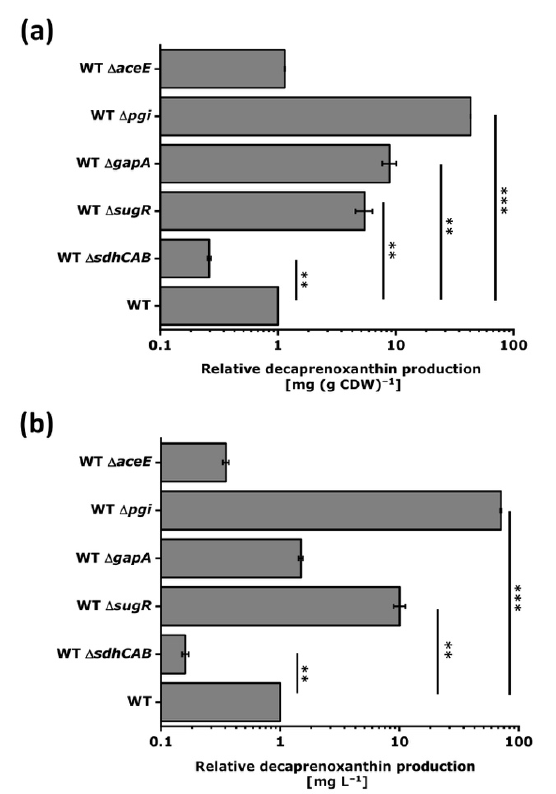
Figure 9. Relative decaprenoxanthin production by C. glutamicum strains carrying various deletions. Cells were grown in 40 g L − 1 of glucose CGXII minimal medium. C. glutamicum WT Δ aceE was grown with 20 g L − 1 of potassium acetate and 40 g L − 1 of glucose in CGXII minimal medium. Decaprenoxanthin production was determined by HPLC analysis. Due to the medium differences, decaprenoxanthin contents in mg g − 1 CDW ( a ) and concentrations in mg L − 1 ( b ) were normalized to the values obtained with the parental WT strain. Mean values and standard deviations of triplicates are given. The p -values of <0.001 (***), and <0.01 (**) were calculated using Student’s t-test (two sided, unpaired). For abbreviations, see Figure 3.